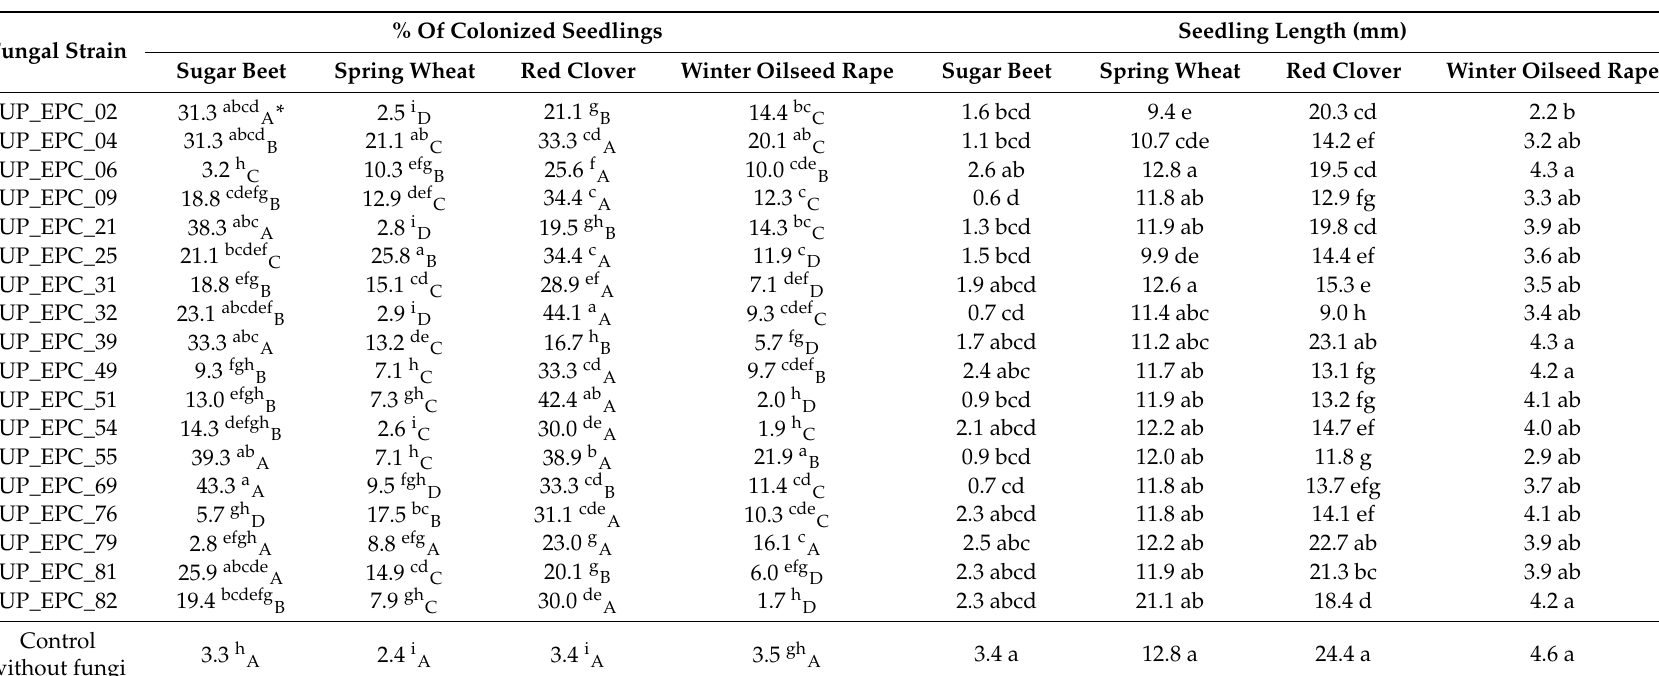
Table A4. The percentage of seedlings of sugar beet ( B. vulgaris L. ssp. vulgaris ), spring wheat ( T. aestivum L.), red clover ( T. pratense L.), and winter oilseed rape ( B. napus L.) colonized by 18 strains of E. nigrum and the length of seedlings of these plants. Fungal